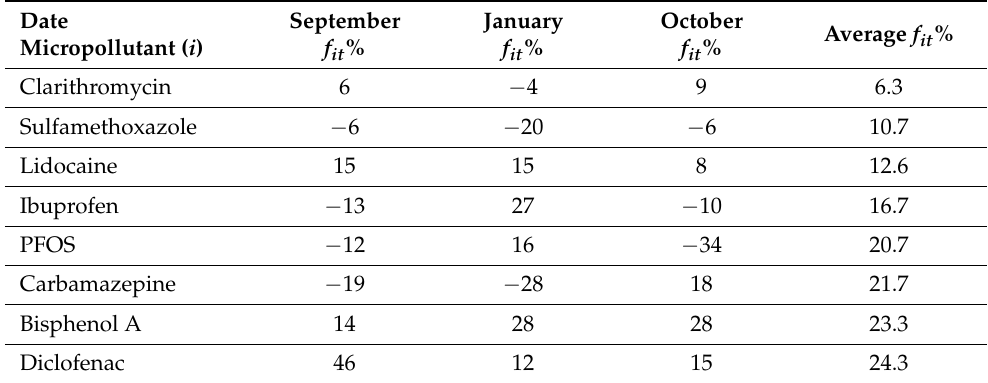
Figure 3. Comparison between the mass flux of micropollutant at the site A 3 ( F A 3 ) and the sum of the mass fluxes at sites A 2 and B 2 ( F A 2 + F B 2 ) for the various micropollutants. The solid line represents the perfect agreement between the mass fluxes and reads as F A 3 = ( F A 2 + F B 2 ). The dotted line corresponds to the fit of all the data: F A 3 = 0.898 ( F A 2 + F B 2 ) + 0.519 (R 2 = 0.9571). Table 4. Mass-balance precision percentage ( f it %) at the confluence of river A and river B for the quantified micropollutants during the three sampling periods. The last column gives the average of f it % in the three sampling periods for each micropollutant (average f it %). The components are ranked in ascending order of average f it